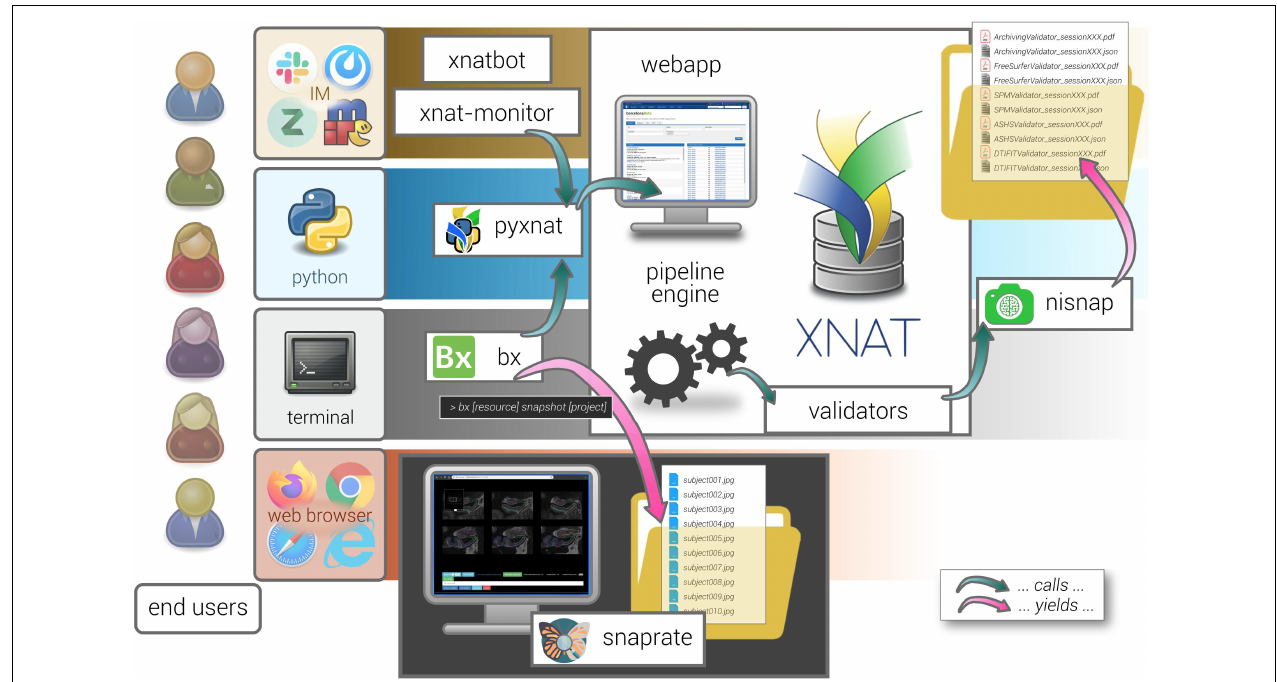
FIGURE 5 | General view on the XNAT-based ecosystem architecture. The different satellite tools described in this manuscript are represented with their mutual interactions. Each of them is based on a specific type of user interaction, e.g., command line, scripts, web browser, and instant messaging (IM). Interaction with XNAT (e.g., xnatbot, xnat-monitor, bx, nisnap) relies on the pyxnat library. Validators are run as pipelines and produce reports (calling nisnap for snapshot generation). Snapshots are collected from any given XNAT project thanks to one of bx’s commands ( snapshot ) and passed to snaprate for visual quality